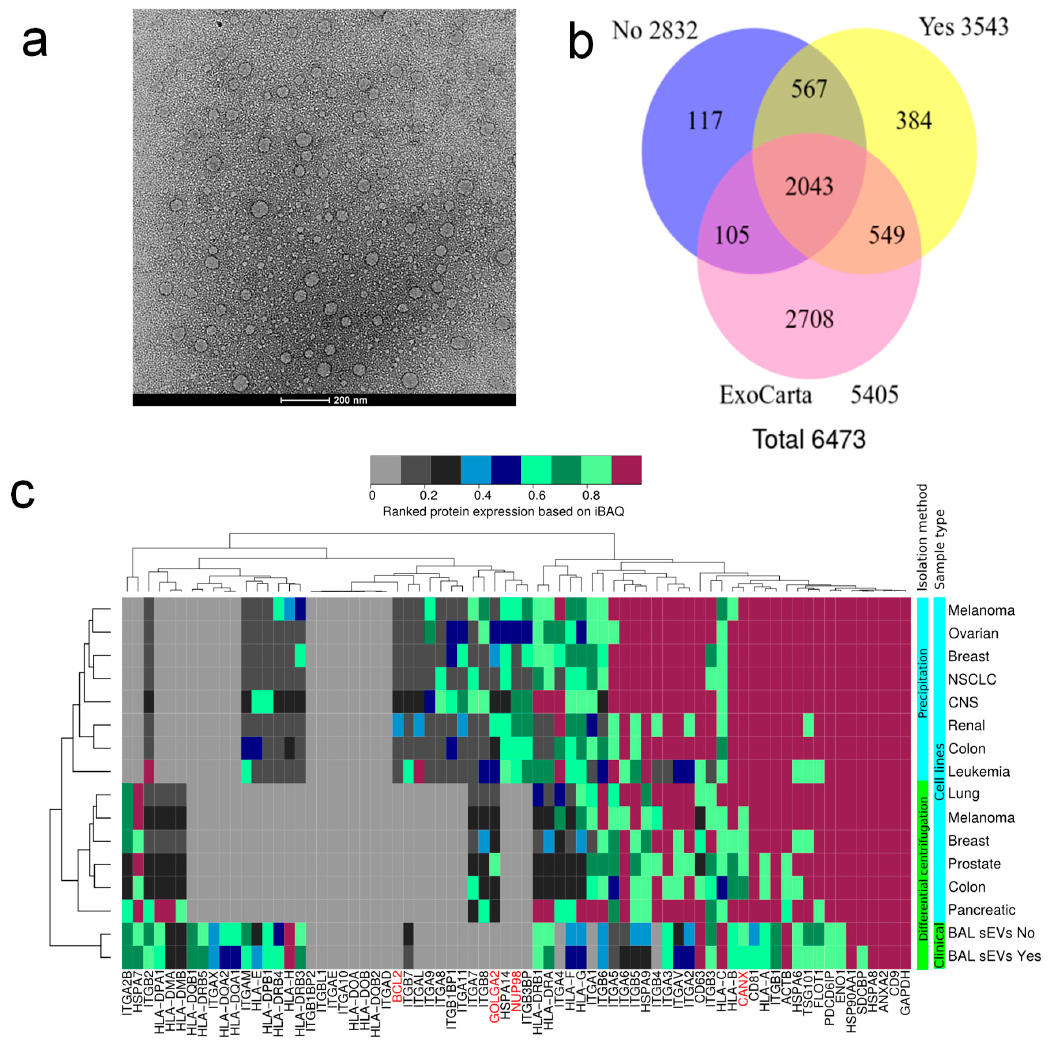
Figure 3. Extracellular vehicle (EV) quality assessment: ( a ) representative transmission electron microscopy images of enriched sEVs; ( b ) Venn diagram indicating overall protein identification overlap with ExoCarta database; ( c ) MS-based quantitative comparison between enriched BAL sEVs and cell line isolated EVs of frequently reported exosome protein markers and 10 most abundant exosome marker from ExoCarta. Red labeled proteins indicate non EV